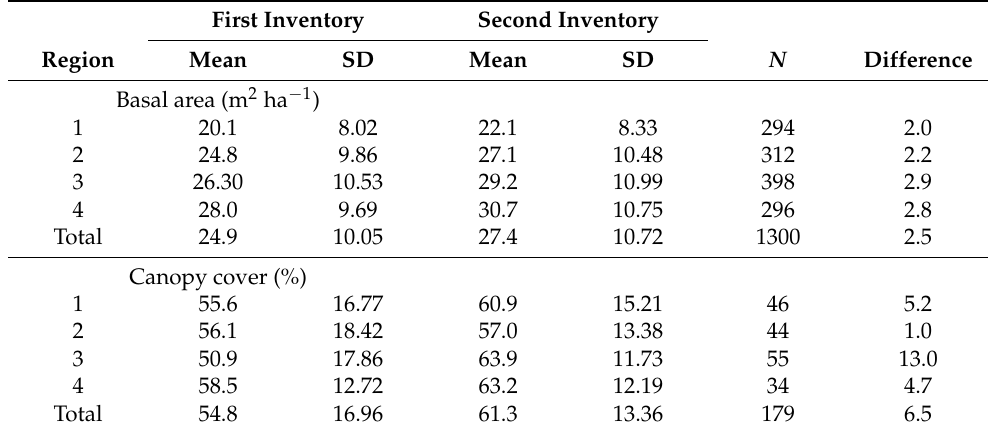
Table 2. Changes in basal area and canopy cover over the 10-year period.